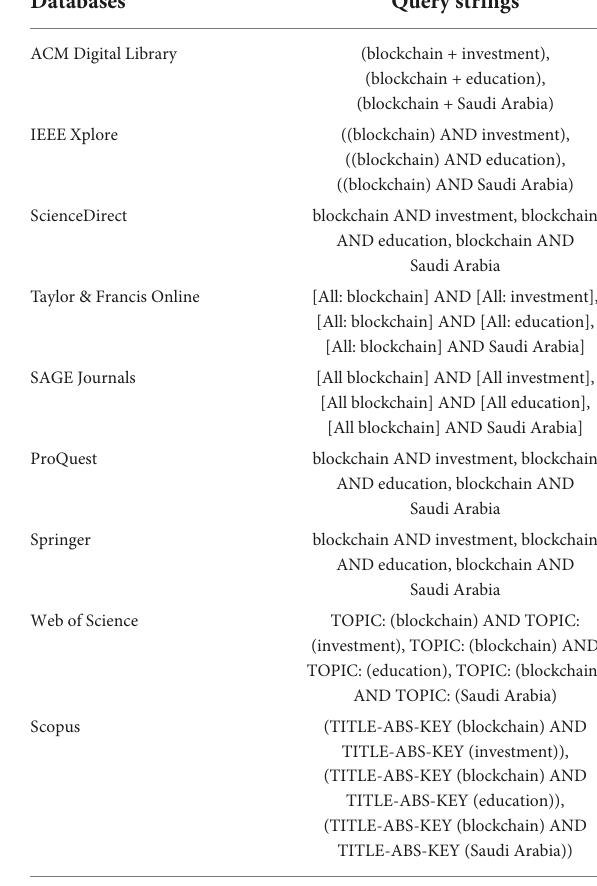
TABLE 2 Adapted query strings for the systematic literature search.